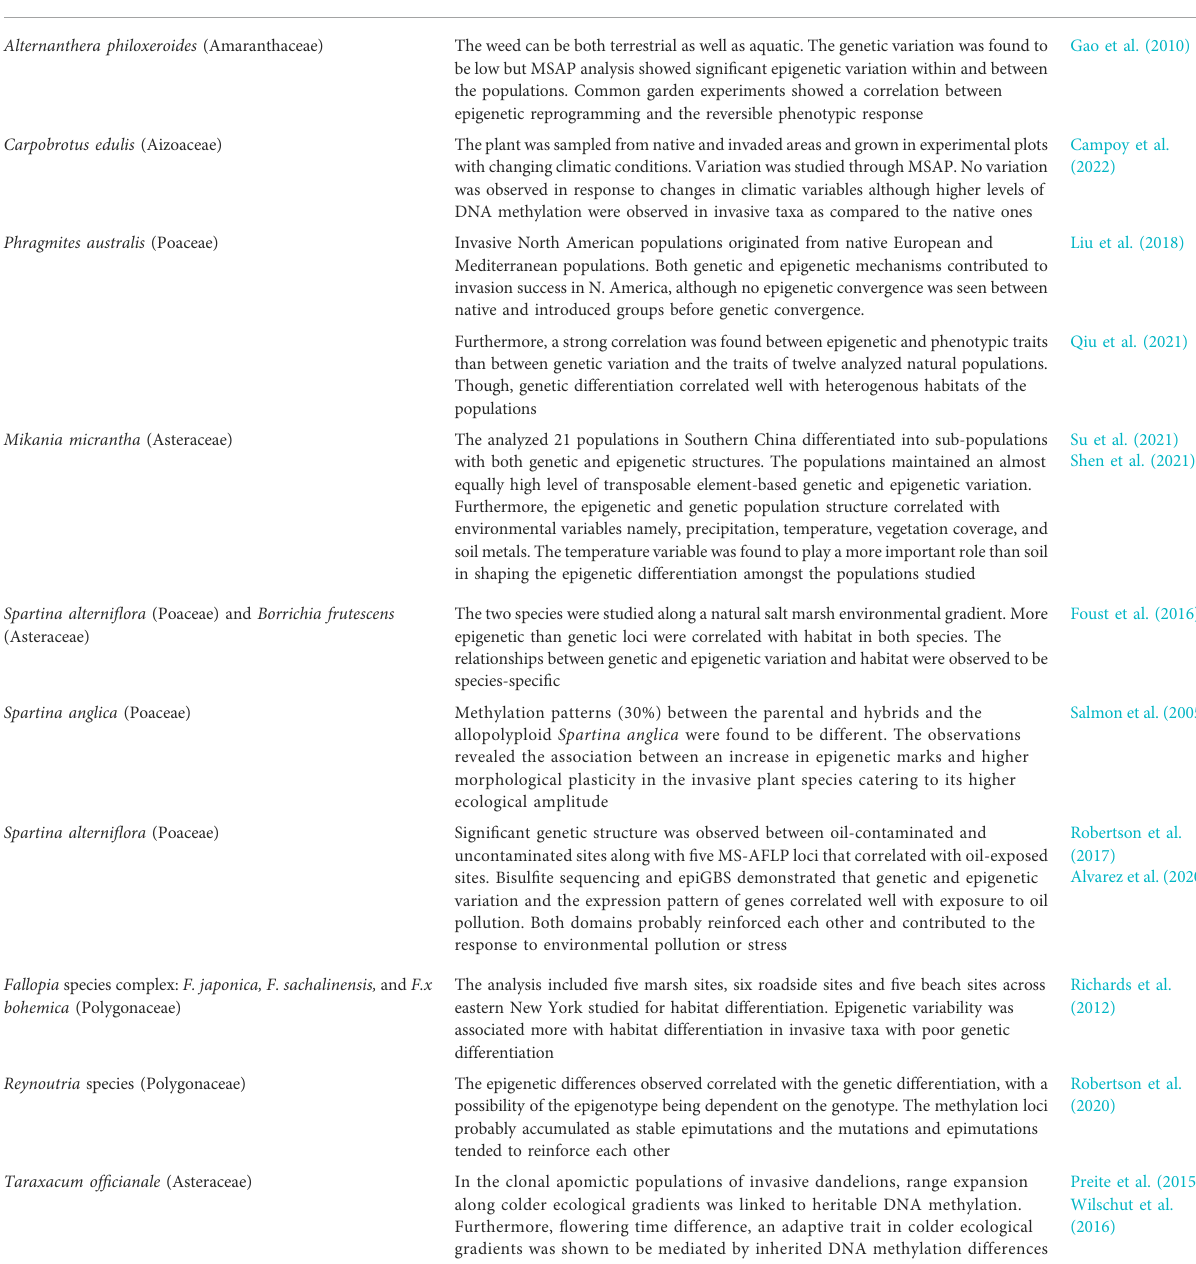
TABLE 4 Studies on epigenetic regulation in invasive plant